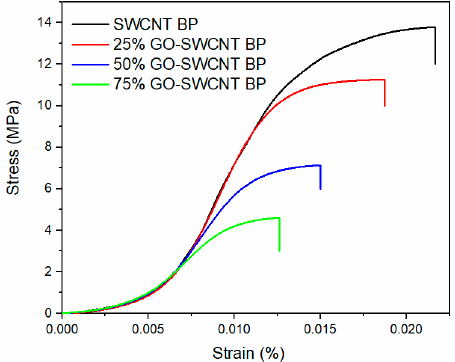
Figure 3. Stress-strain curves of SWCNT BP with different weight percentage of GO. Table 1. Mechanical properties, water contact-angles, and the porosity of SWCNT BP with different weight percentage of graphene oxide